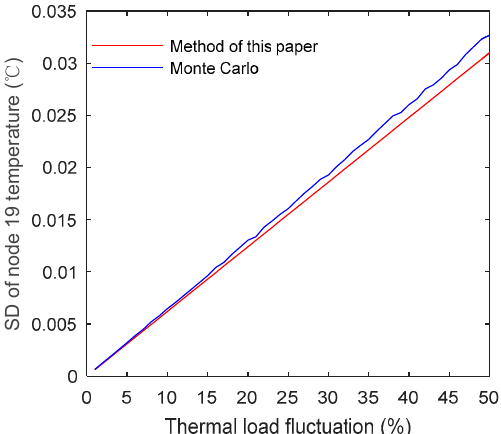
Figure 7. Relationship between the node temperature standard deviation of node 19 and thermal load fluctuation (Test 4: L = 500 m; μ ϕ = 1.0 MW).